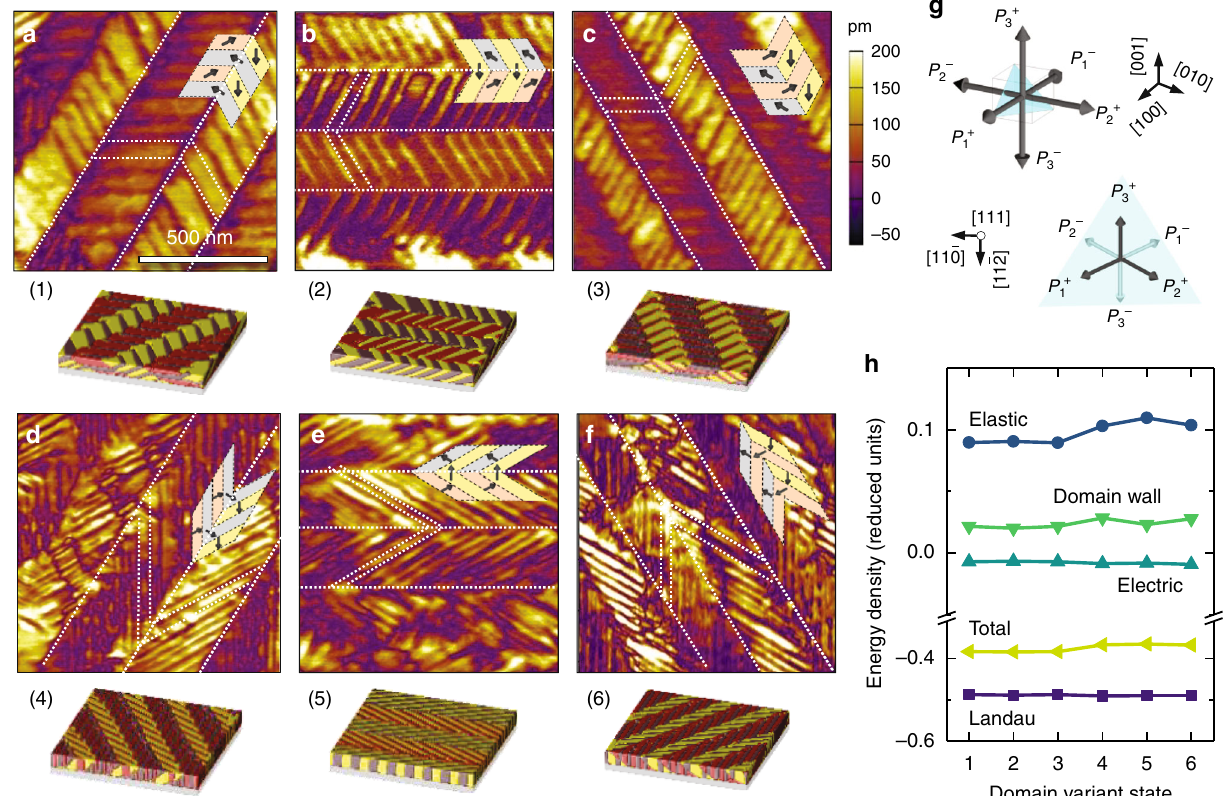
Fig. 1 Piezoresponse force microscopy characterization of domain structures. Piezoresponse force microscopy phase images a – c of fully down-poled Type-I twinning structures (1/4 area P 1 − and P 3 − with 1/2 area of P 2 − or cyclic permutations of the 3 directions) and d – f of Type-II twinning structures (1/4 area − and P − with 1/2 area of P + or cyclic permutations of the 3 directions) which exhibit zero net out-of-plane polarization. g Schematic of the six possible P 1 3 2 polarization variants ( P 1 + and P 1 − shaded in pink, P 2 + and P 2 − in blue, P 3 + and P 3 − in yellow) in (111)-oriented tetragonal ferroelectrics and their corresponding projections onto the [111]. h Phase- fi eld simulation of various energetically degenerate domain structures (1) – (6) and the extracted total, Landau, electric, elastic, and domain-wall energies of the